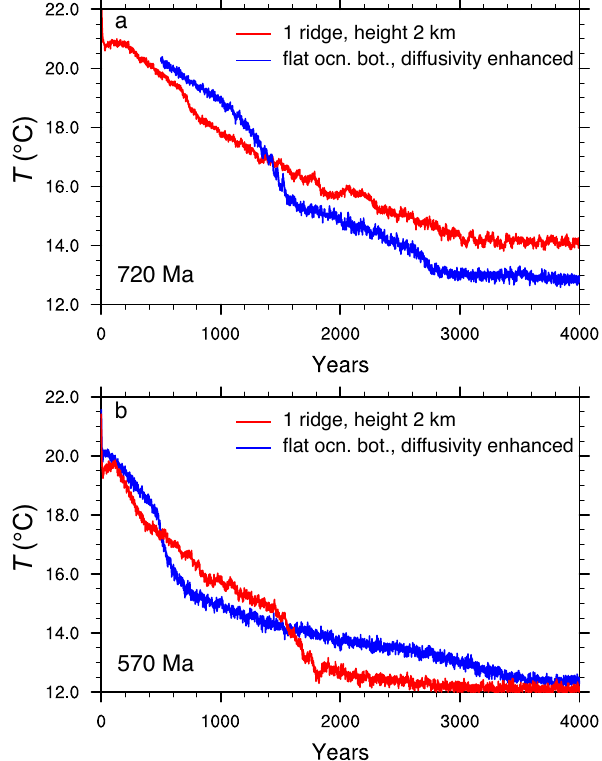
Fig. 3. Time series of global mean surface temperature of the control simulations for both (a) 720Ma and (b) 570Ma continental config- urations. TSI is 94%TSI 0 , p CO 2 is 2000ppmv, τ is 0.12 for all four runs. The red curves are obtained for the model in which a straight ridge (e.g., Fig. A1) of height 2km is added to the ocean bottom (i.e., the RIDGE method), while the blue curves are obtained for flat ocean bottom but bottom drag is increased by a factor of 100 and the isopycnal and thickness diffusivities are increased by a factor of 5 (the DIF method). The blue curves will be used as the control simulation from the end of which branch runs are